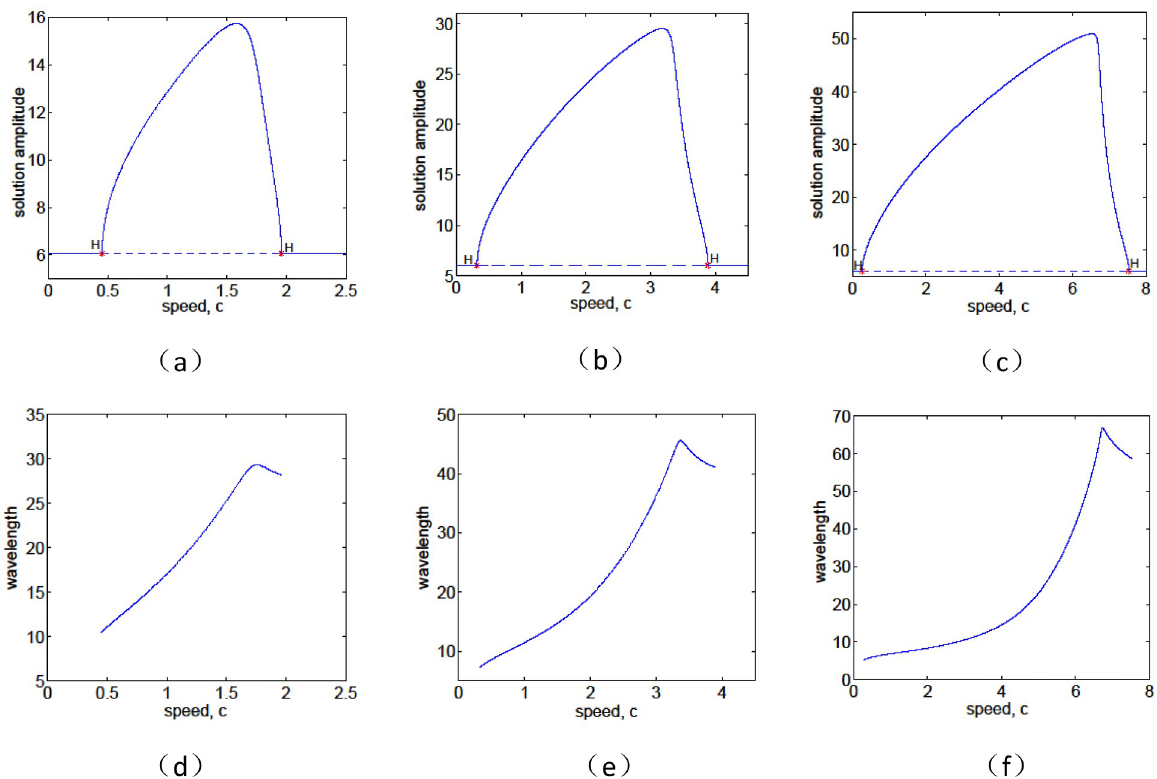
Fig 6. Effects of α on the amplitude, wavelength and wave speed of stripe pattern solutions with the parameter values p = 2.8, v = 182.5 and δ = 0.45. (a), (b), (c): typical bifurcation diagrams and spatial solutions of model (14) with (a) α = 0, (b) α = 0.01 and (c) α = 0.03. Here the homogeneous steady state is stable (solid dark line) for large values of the speed c , but unstable (dashed line) at intermediate values of c . The changes in stability occur via Hopf bifurcations (denoted by H) from which branches of periodic orbits emanate, which indicates that stripe patterns of biomass emerge. (d), (e), (f): the wavelength along the periodic orbit branches varies with different speed.